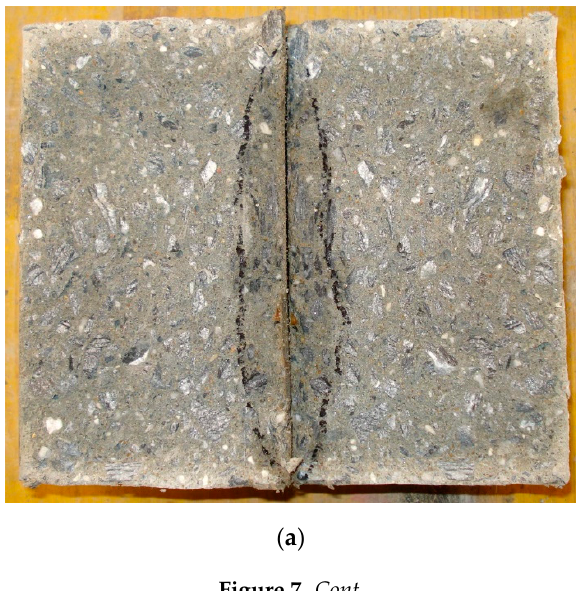
( b ) Figure 7 (a) Concrete specimens cut in half made from Bündner Schist (Figure 7a) and (b) Quartz Phyllite (Figure 7b) after water penetration testing showing only a short water penetration distance. The average penetration depth in case of Bündner Schist aggregate is 19 mm, and for Quartz Phyllite aggregate 20 mm, indicating a dense concrete structure for both aggregate types. Therefore, the mixtures reach the highest exposure class, XC4, regarding carbonation (according to the European standard EN 206-1 for specification, performance, production and conformity of concrete), verifying the usability of recycled rock as aggregate for concrete manufacture [30]. All things considered, the preliminary concrete tests showed that concrete production using recycled aggregate is possible, also in the case of application of processed excavation rock material for all particle size classes. 5. Excavation Material Processing at the Brenner Base Tunnel 5.1. General Preliminary practical studies started in 2010 followed by large-scale processing experiments during an early stage of tunnel driving. On the basis of the results, a material processing and plant concept was developed and subsequently implemented during tunnelling at the construction section Wolf II in Steinach/Brenner (see Figure 3). There, an access tunnel towards the main tunnel tubes with